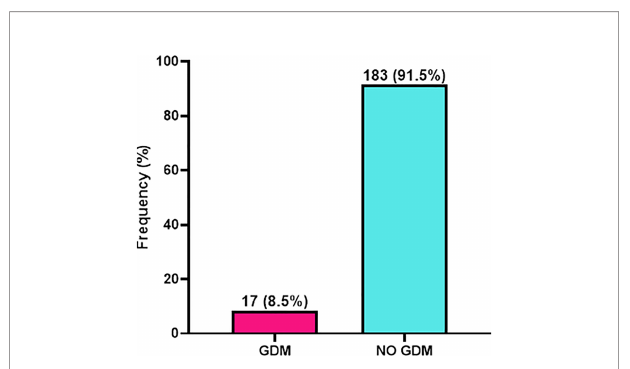
FIGURE 1 | Prevalence of gestational diabetes mellitus (GDM) among